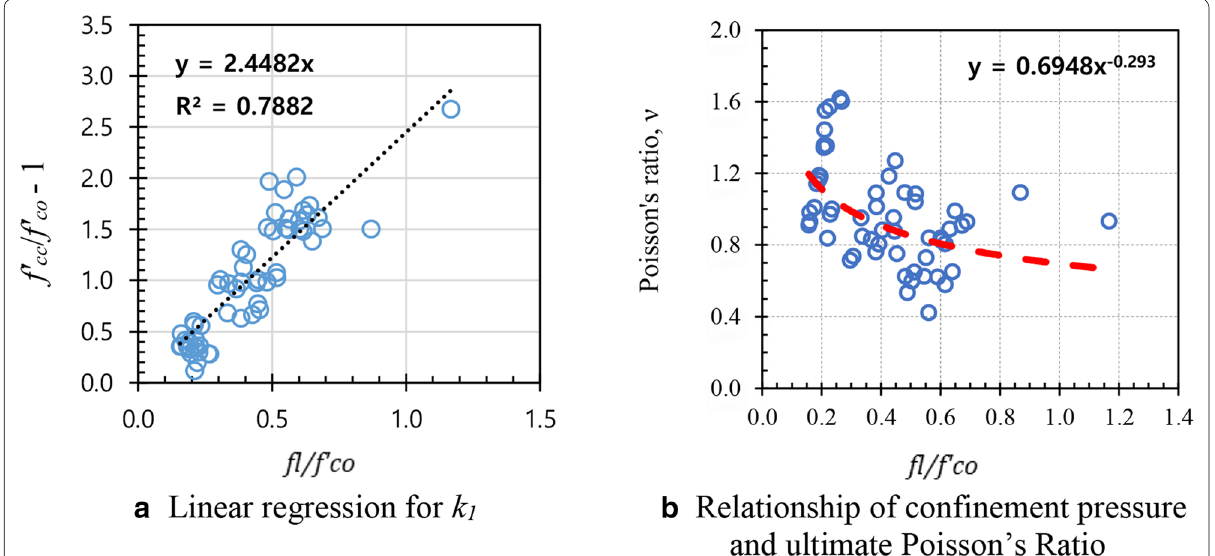
Fig. 18 Regression analyses of merged test data by authors, Dai et al. (2011) and Saleem et al. (2018).